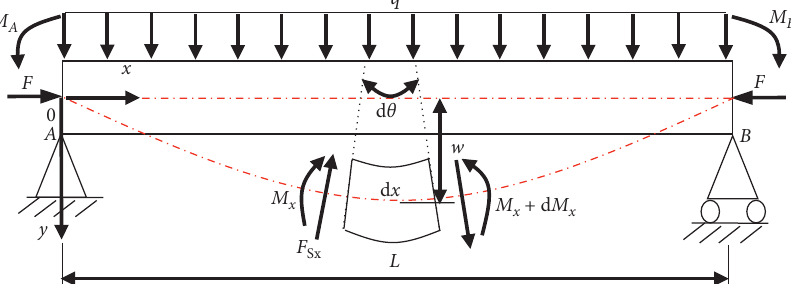
Figure 10: Simplified model of the fixed support rock beams undergoing the effects of horizontal concentrated